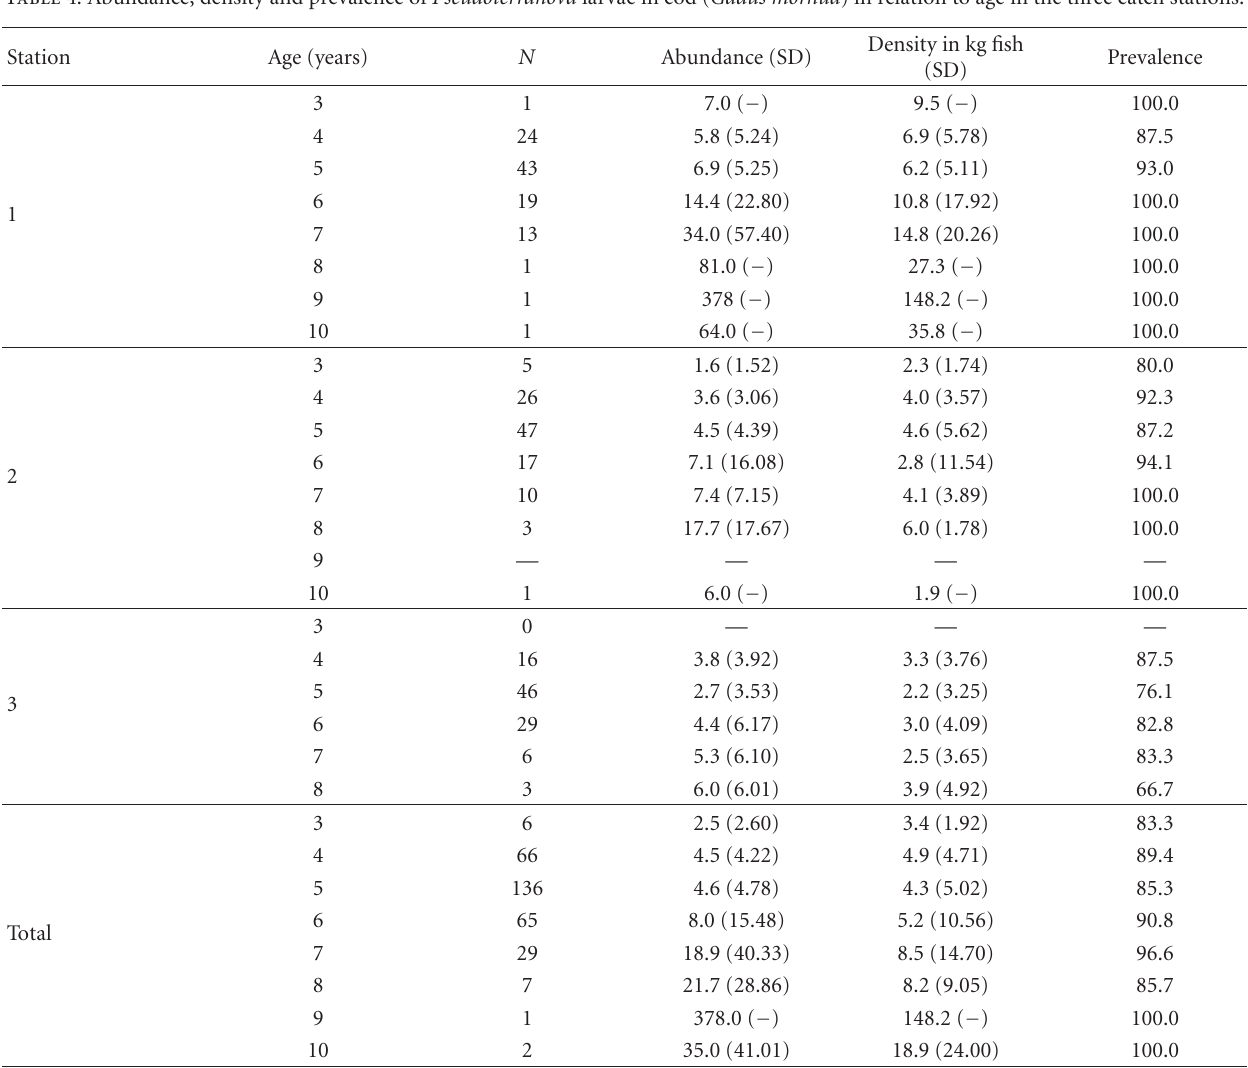
Table 4: Abundance, density and prevalence of Pseudoterranova larvae in cod ( Gadus morhua ) in relation to age in the three catch stations.